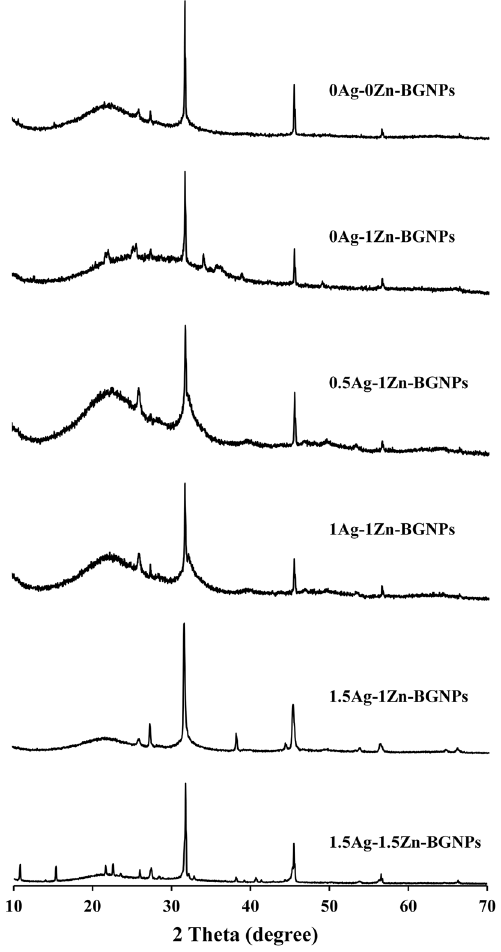
Figure 5. XRD spectra of BGNPs after incubation in the SBF solution for 21